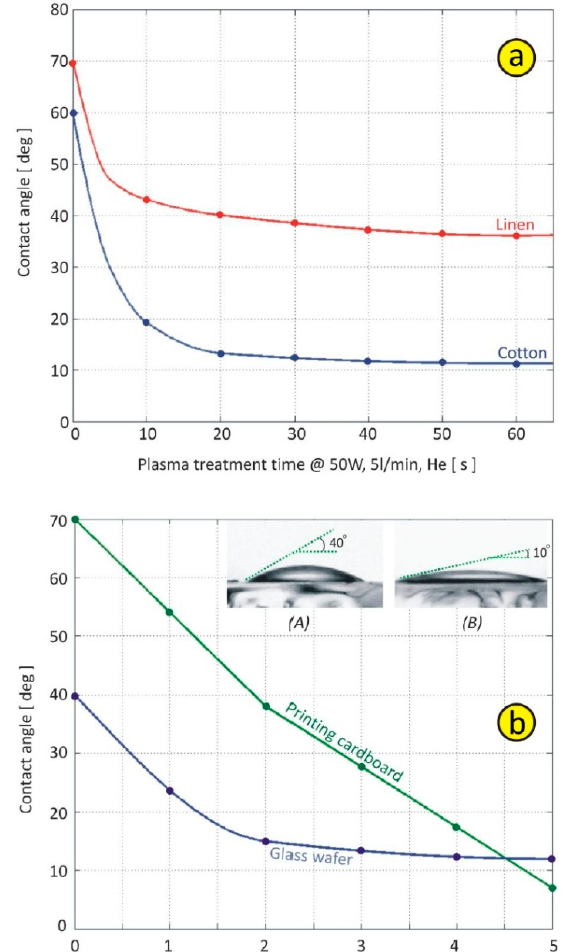
Figure 8. ( a ) Contact angle variation on plasma-treated cotton and linen samples. ( b ) Plasma-treated glass wafers and cardboardat50 W input power, as a function of treatment